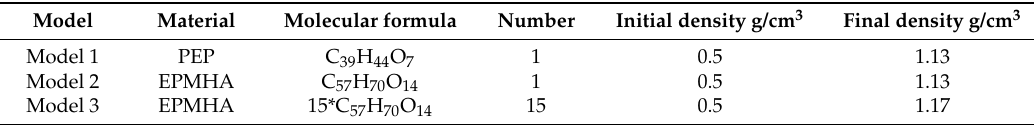
Table 1. Model construction. EPMHA: epoxy resin cured by methyl hexahydrophthalic anhydride; PEP: pure epoxy resin.